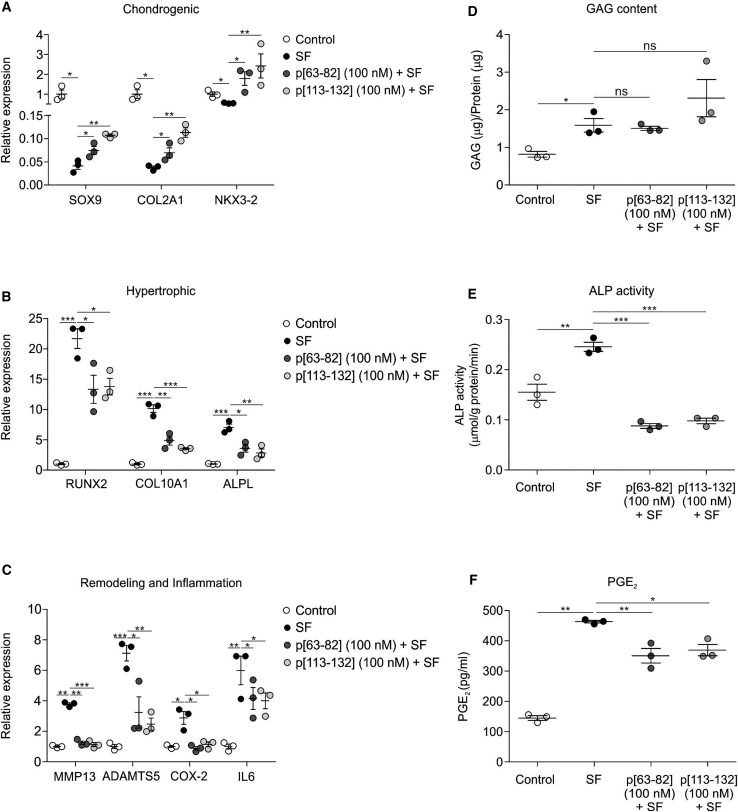
Bioactivity of peptides p[63−82] and p[113−132] on OA articular chondrocytes in OA synovial fluid (SF)OA-HACs (n = 3 individual donors, tested in triplicate) were exposed to 100 nM peptide p[63−82] or p[113−132] in the presence of OA SF (20% [v/v]; equal ratio mix from five individual donors). Control is 20% (v/v) 0.9% NaCl. Cells were cultured in these conditions for 24 h and analyzed for mRNA expression of indicated genes (normalized for 28S rRNA expression and relative to control condition). (A) Expression of SOX9, COL2A1, and NKX3-2 mRNAs. (B) Expression of RUNX2, COL10A1, and ALPL mRNAs. (C) Expression of MMP13, ADAMTS5, COX-2, and IL-6 mRNAs. (D) GAG content (normalized to total protein content) was determined in the same conditions. (E) ALP enzyme activity in cell lysates of the same conditions was determined and normalized for total protein content. (F) PGE2 levels in culture supernatants of the same conditions. Error bars represent mean ± SEM, and statistical significance for peptide conditions or control versus SF condition as determined by unpaired two-tailed Student’s t test is represented as ∗p < 0.05, ∗∗p < 0.01, and ∗∗∗p < 0.001.